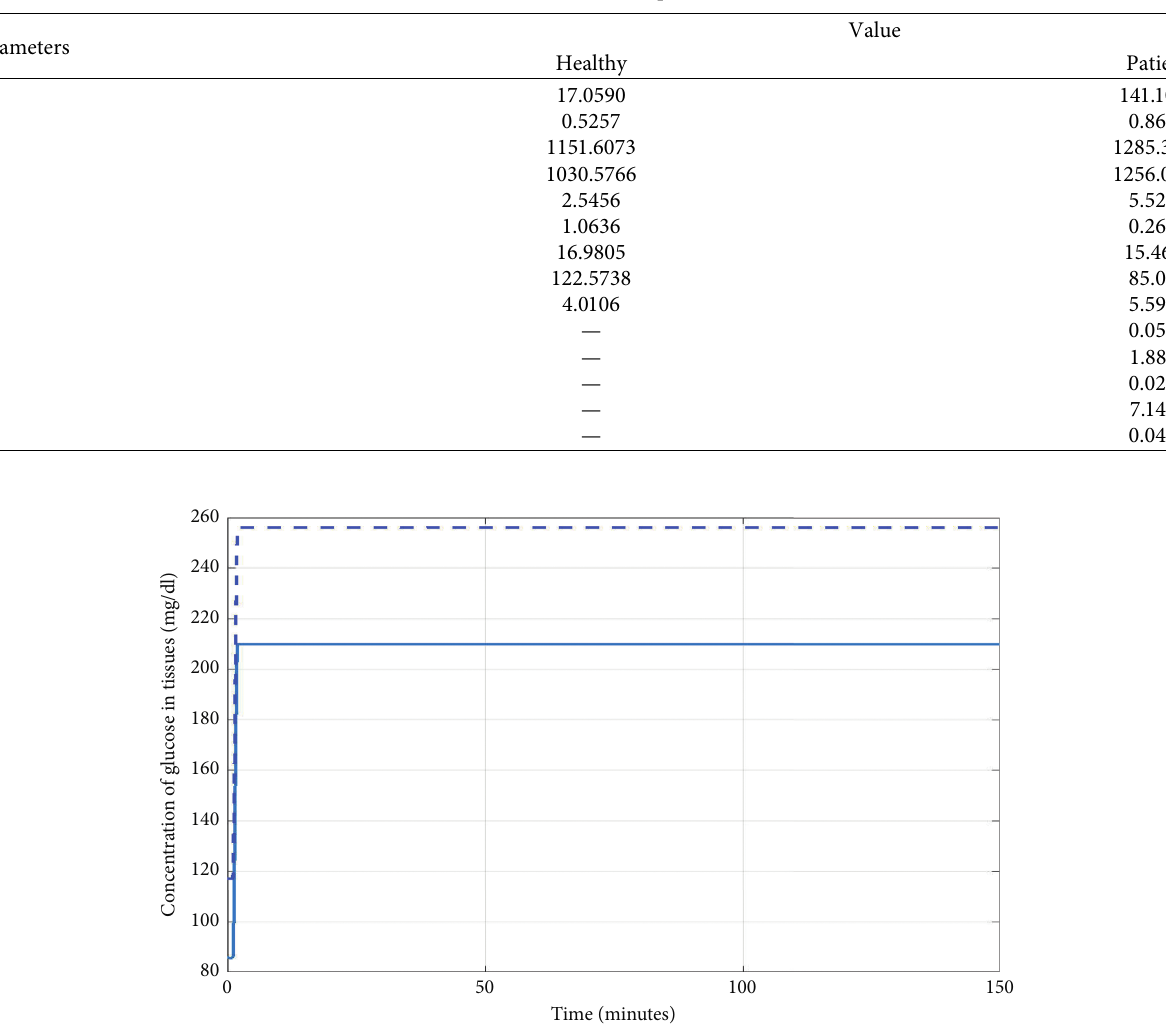
Figure 4: Profile of glucose in tissues during euglycemic hyperinsulinemic clamp test. The dashed line shows the type 2 diabetic patients hyperglycemic clamp test, while the solid line shows the same for healthy subjects.